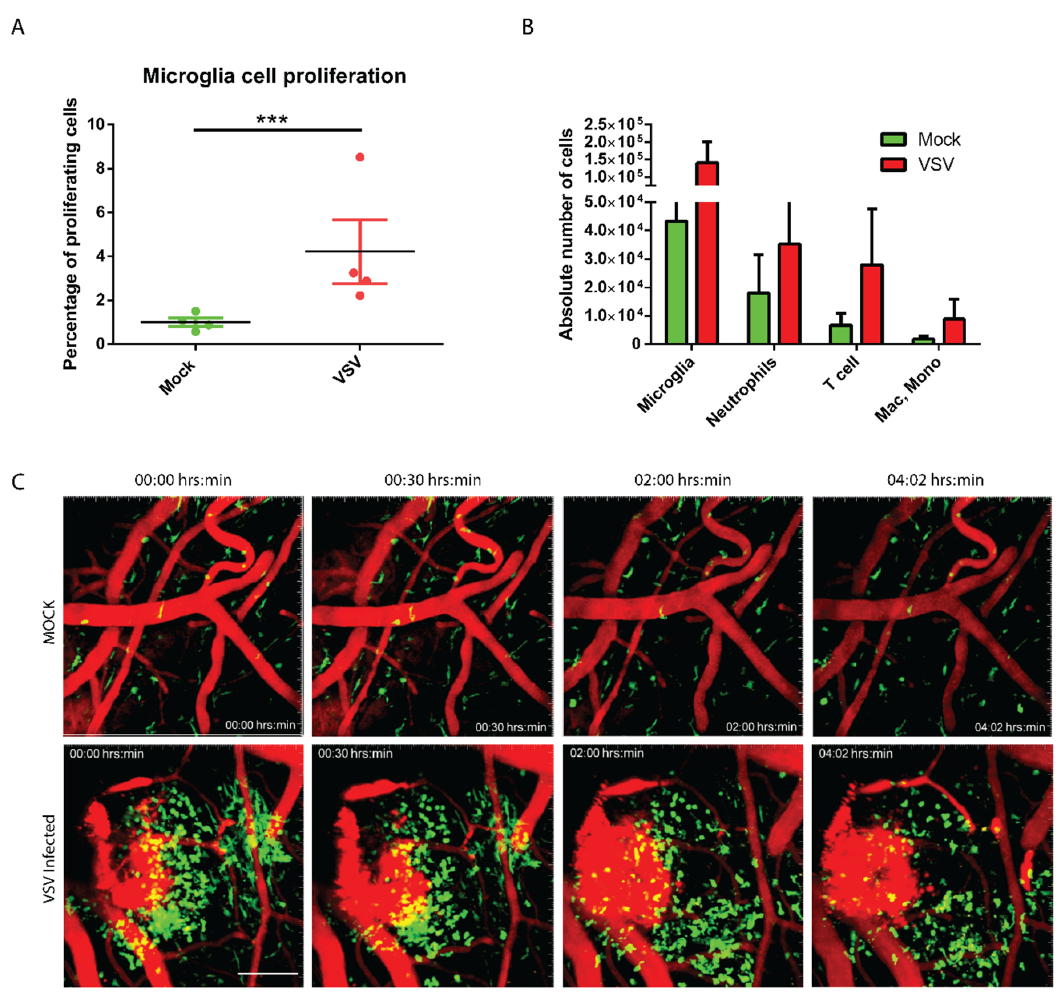
Figure 2. VSV infection in CNS induces microglia proliferation and myeloid cell recruitment. Mice were either infected with 10 4 PFU of VSV or mock-infected. At day two post-infection, the total CNS myeloid cell populations were analyzed by flow cytometry. ( A ) Representative dot plot showing the percentage increase in the number of microglia (CD45 low , Thy1.2 − , Gr1, and CD11b + ) population in VSV-infected mice brain ( n = 4 per group). An asterisk denotes statistical significance, *** denotes p value < 0.001. ( B ) The bar graph represents the absolute count of myeloid cells obtained from mice brain ( n = 4): microglia, neutrophils (CD45 low , Thy.12 − , CD11b + Gr1 + , and Ly6C med ), monocytes, and macrophages (CD45 low , Thy.12 − , Gr1 − , CD11b + , and Ly6C high ) in the CNS of mice ( n = 4 per group) following VSV infection. Note an increase in the CNS myeloid cell number in VSV-infected animals compared to the mock-infected animals ( p > 0.05). ( C ) The two-photon light scanning microscopy (TPLSM) was performed through a surgically thinned skull window in mock-infected LysM-GFP reporter mice (upper row) and compared to VSV-infected mice at day three post-infection (lower row). Representative figure showing an increase in the number of cells infiltrated in the brain parenchyma (see corresponding movies Videos S1 and S2). Blood vessels are represented in red, and macrophages, monocyte, and neutrophils are represented in green. Please note the presence of prominent vascular leakage (damaged blood vessels in red) in the VSV-infected brain. Surrounding this, a cluster of infiltrating cells are observed at the beginning of the movie; these cells later shifted to elsewhere over a time period of 4 h.